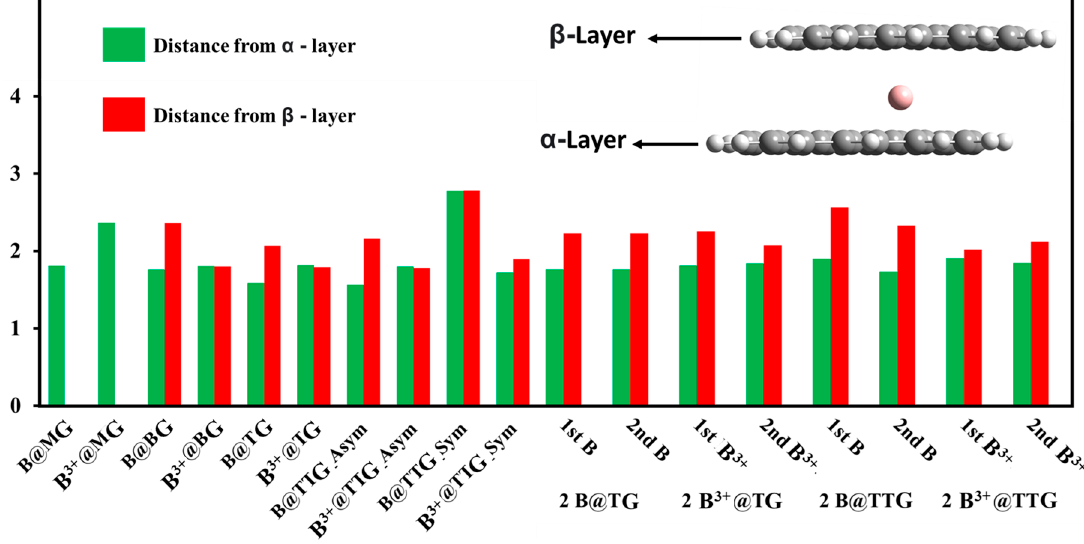
Figure 3. The distance between the graphene layers ( α -layer and β -layer) and the boron species (B and/or B 3+ ). The green bars represent the “ α -layer”-B/B 3+ distance while the red bars represent the “ β -layer”-B/B 3+ distance.